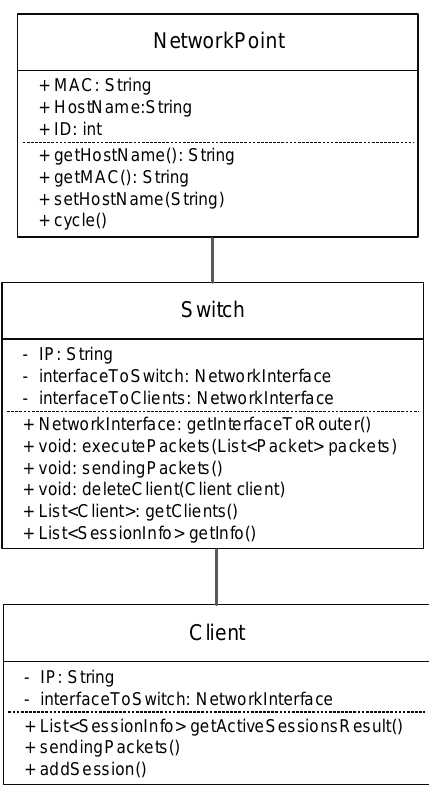
Figure 11. The UML diagram for switch class.